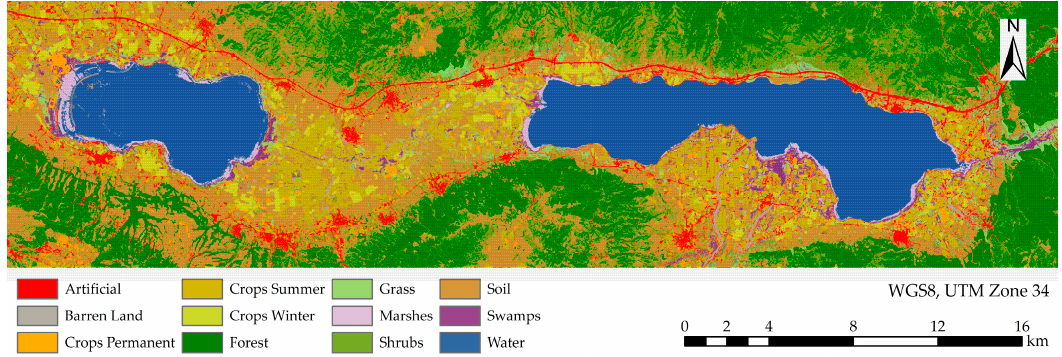
Figure 9. The final classified image after the post-classification corrections (PCC).